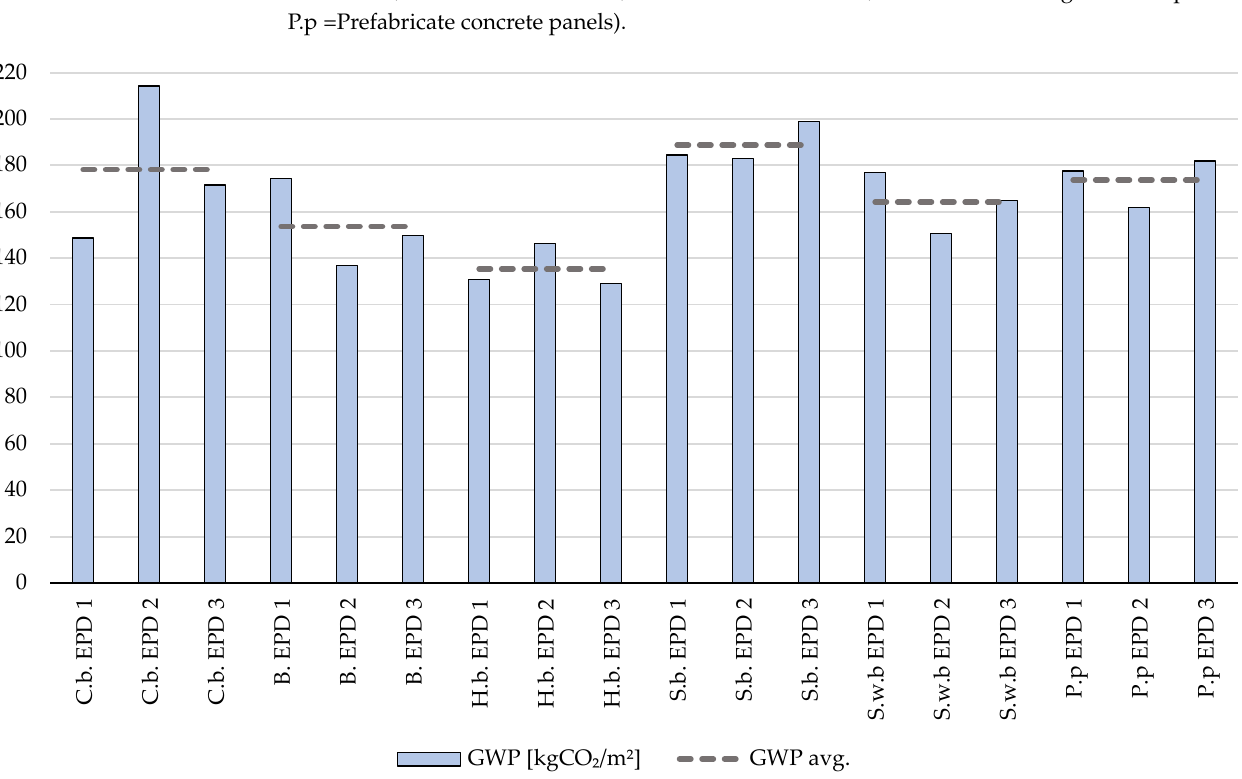
Figure 12. GWP A1–A3|LC for each wall model considered. (C.b. = Concrete block; B. = Bricks; H.b = Hollow bricks; S.b. = Sandstone bricks; S.w.b. = Shuttering wood chips blocks; P.p = Prefabricate concrete